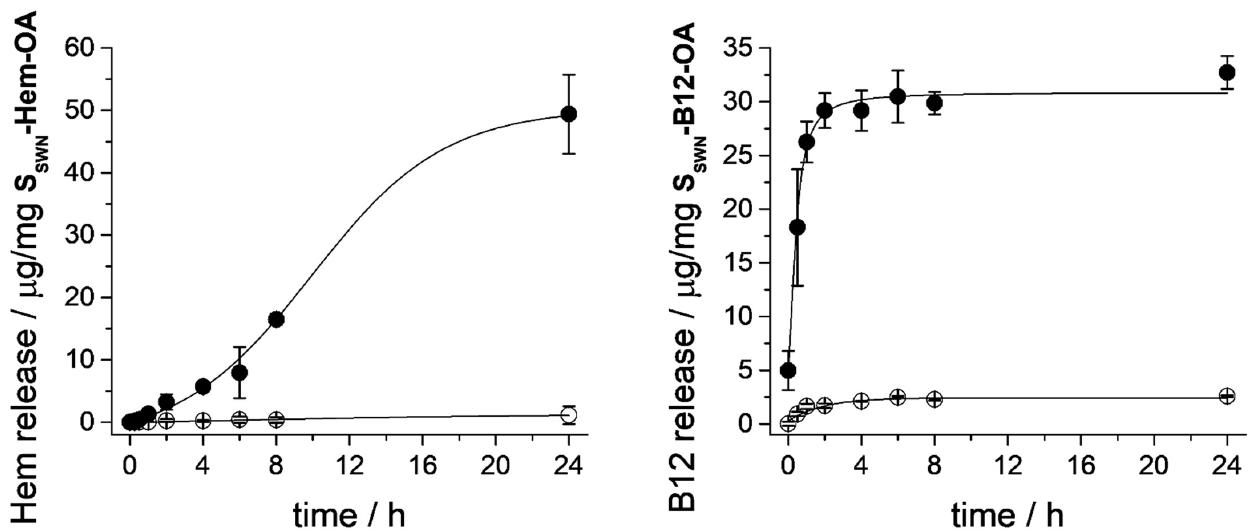
Figure 7. Release profiles of Hem ( left ) and B12 ( right ) from S SWN -Hem-OA and S SWN -B12-OA organonanoclays, respectively. Suspensions of the gated supports in PBS ( ○ ), and in a solution containing CTAB-surfactant molecules ( ).